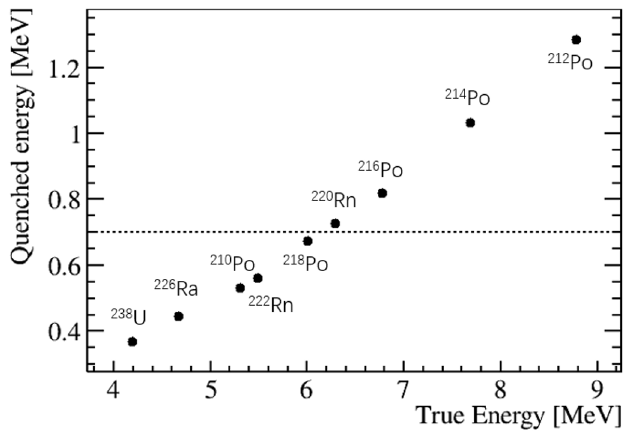
Figure 4. The quenched alpha energy resulting from the SNiPER simulation as a function of the true energy for the main alpha peaks of both 238 U and 232 Th chains is shown as black points. The default 0.7 MeV energy threshold used for IBD event selection is shown with a dashed